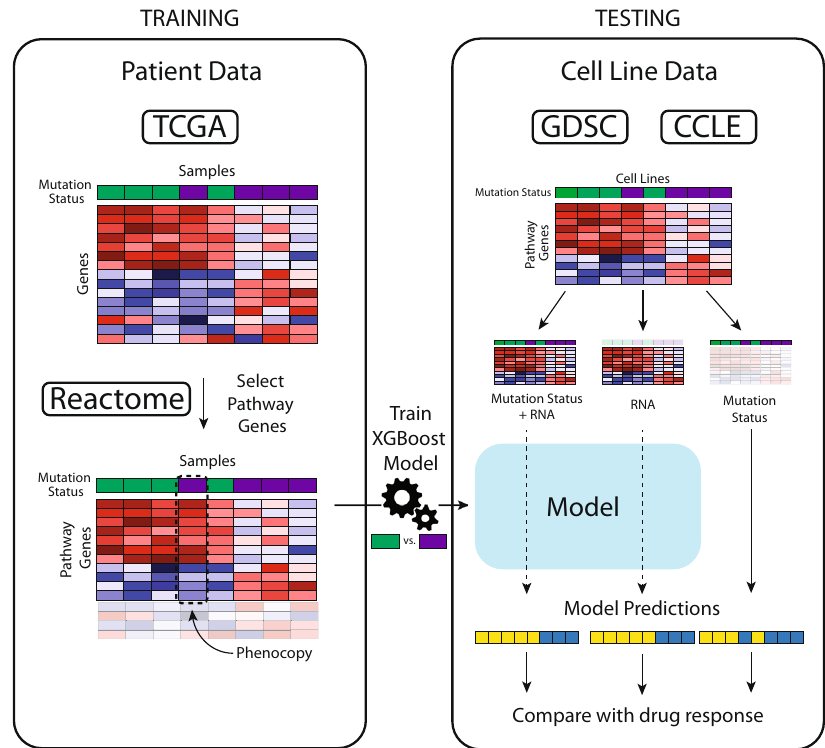
Fig. 1 Schematic of phenocopy signatures model. For each gene of interest, known mutation status is determined (green – mutation; purple – no mutation) and an XGBoost model is trained on mutation status based off gene expression of the pathway of interest and the phenocopy signatures are locked (Training, left). Next, gene expression data from cell line databases or clinical studies are input into the phenocopy signatures which outputs a predicted phenocopy status. This phenocopy status is then compared to known DNA mutations for predicting drug